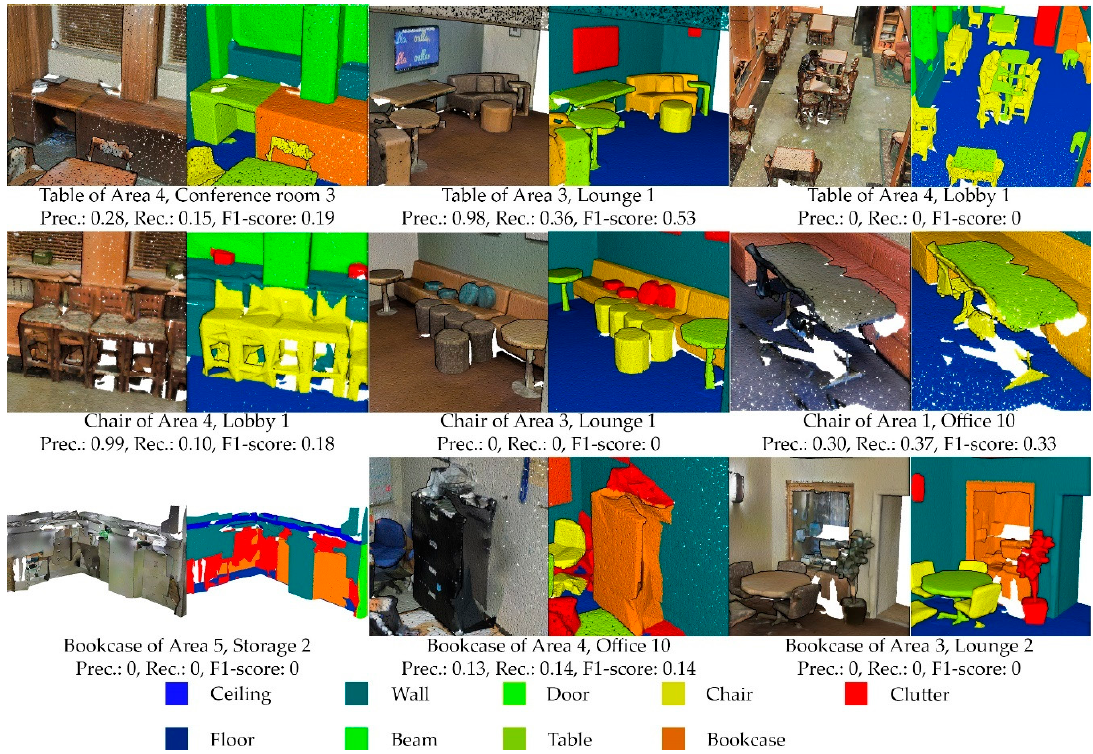
Figure 16: Problematics cases which often include point cloud artefacts such as heavy noise, missing parts, irregular shape geometries, mislabelled data.